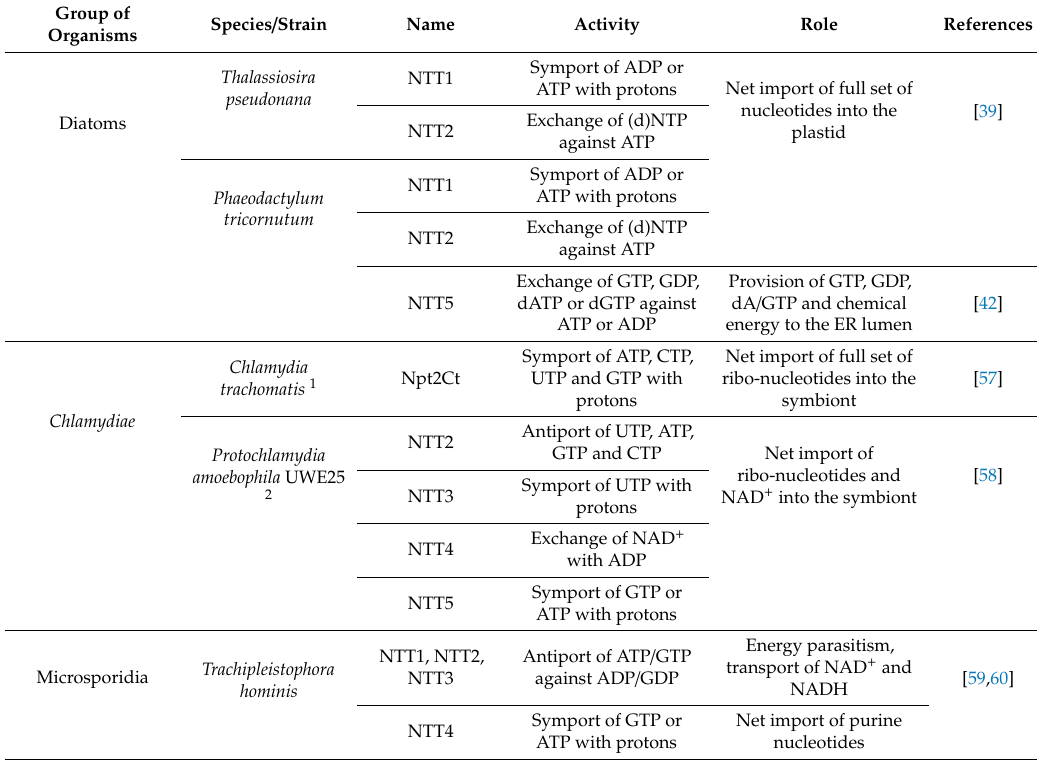
Table 2. NTTs with unusual activities compared to ATP / ADP + Pi antiporters (like the plant NTTs shown in Figure